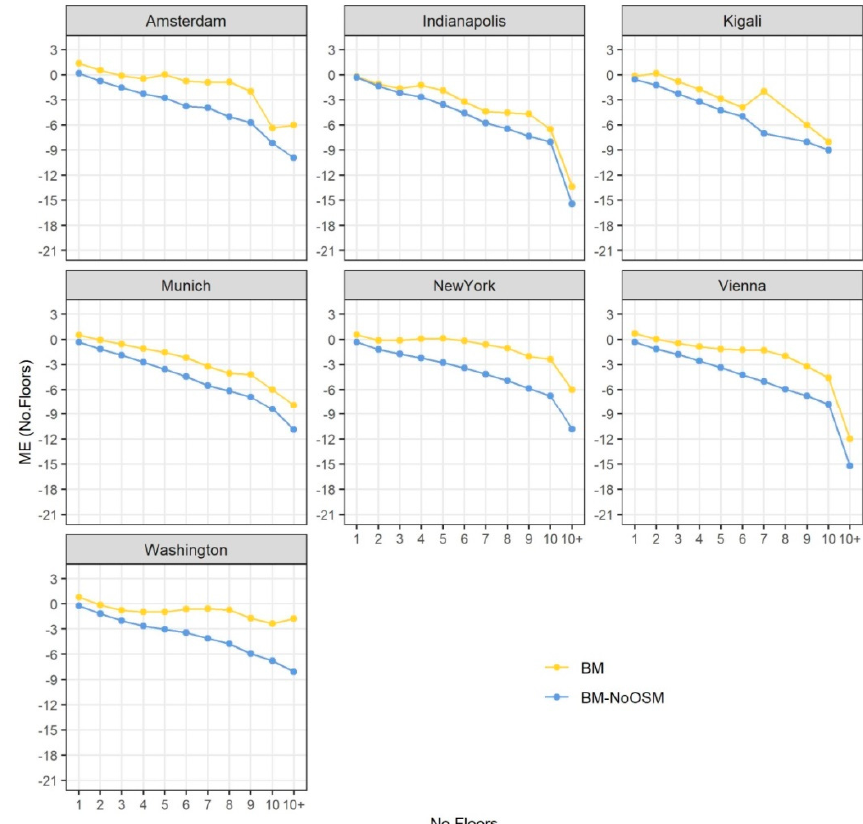
Figure 6. Mean error (ME) reported in the number of floors by each building mask (BM) for each study city.